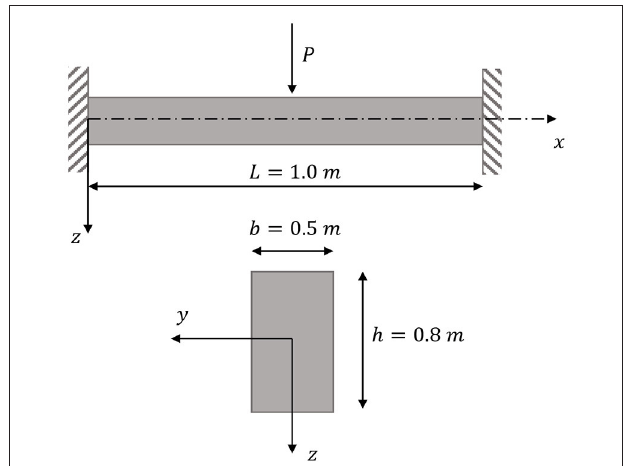
FIGURE 12 | Stress-strain curve for the nonlinear SMA material in Example 3.